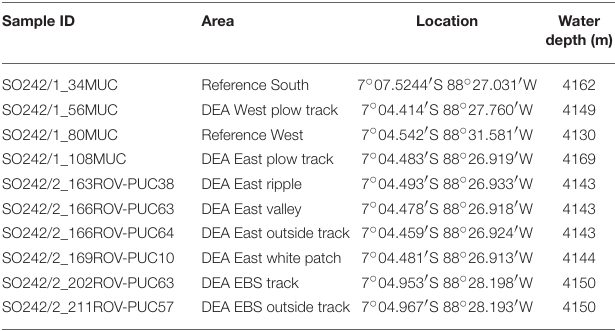
TABLE 1 | Overview of cores taken for sediment and pore water trace metal